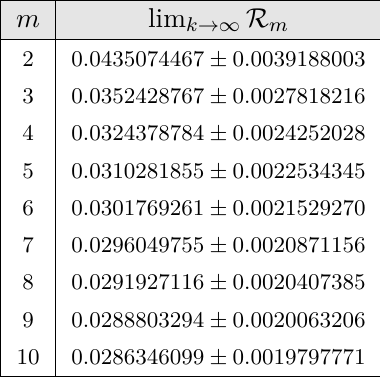
Figure 15. Variation of Rényi entropies for the state | 5 2 # T 2 , 2 i with k